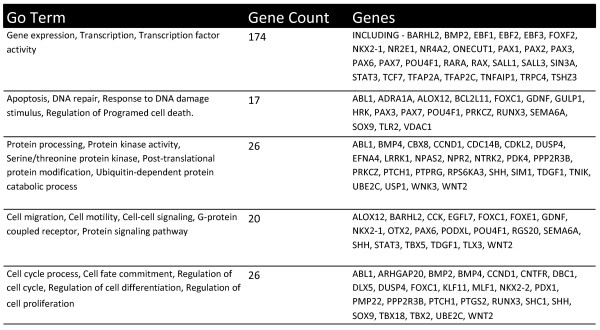
DAVID functional annotation. The table shows the results of using the online DAVID functional clustering and annotation program to cluster the short list of 398 genes in to functional groups and pathways. The analysis revealed that the majority of genes cluster as being involved in transcription, with smaller number of genes involved in functions such as apoptosis, DNA repair, cell cycle progression and cell signalling.